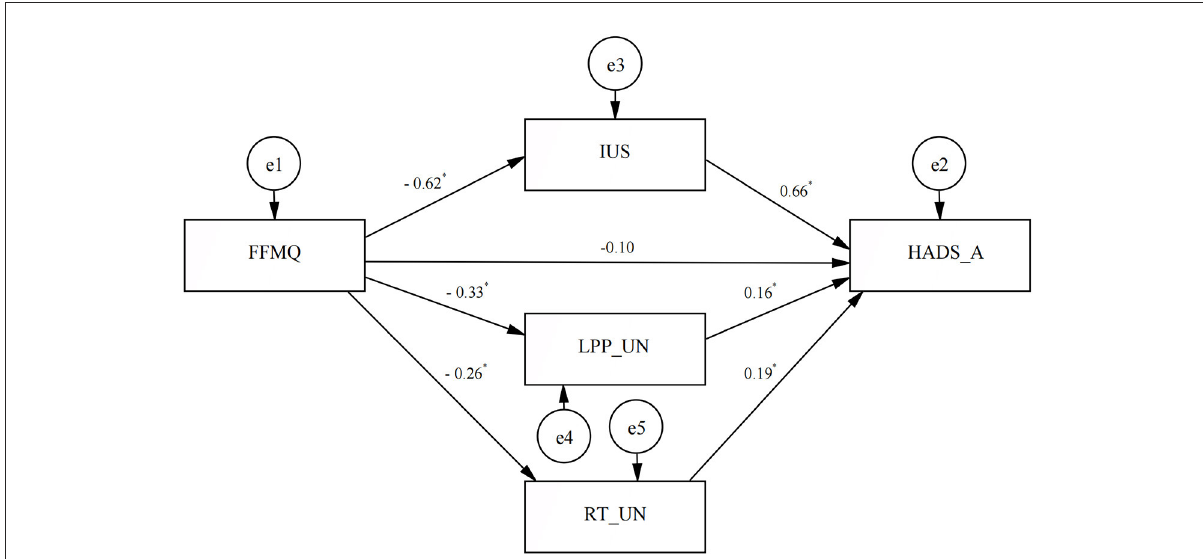
FIGURE4 Mediation model of anticipatory response to uncertain threats to mindfulness improving anxiety. FFMQ, Five Facet Mindfulness Questionnaire; IUS, Intolerance of Uncertainty Scale; HADS-A, Anxiety subscale of Hospital Anxiety and Depression Scale; LPP-UN, the amplitude of LPP